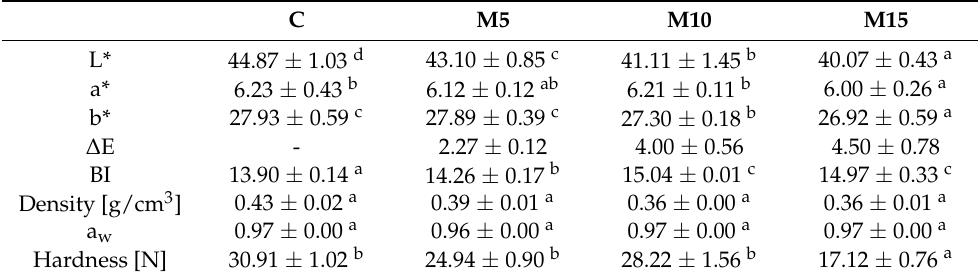
Table 3. Physicochemical properties of obtained breads